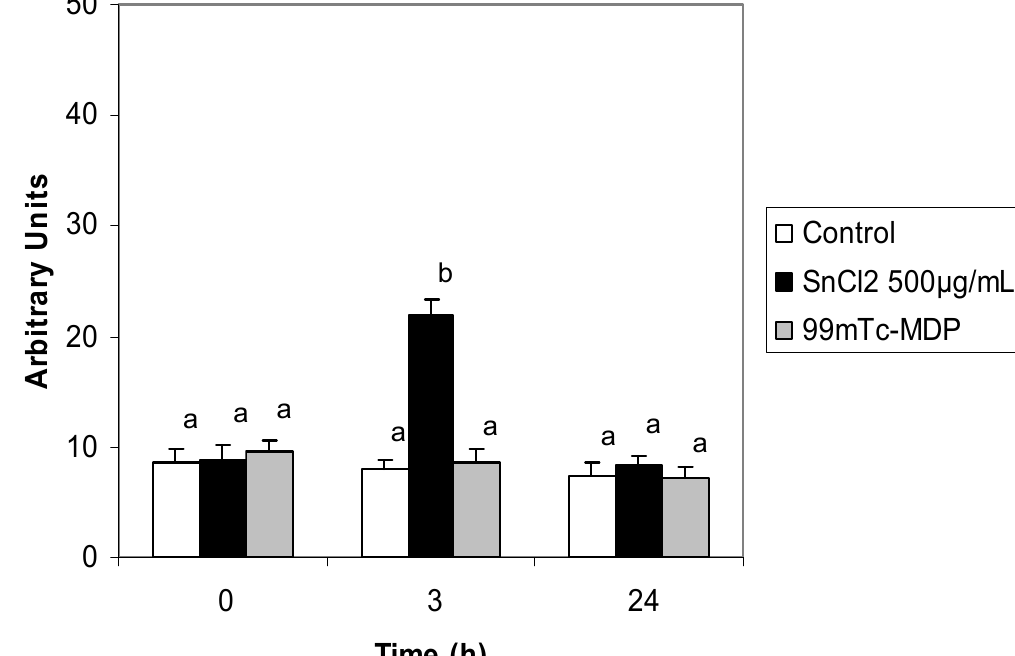
Figure 1. Comet assay of total blood cells of Wistar rats treated with NaCl 0.9% (Control); 500 µg/mL and 99m Tc-MDP. Blood was collected immediately before intravenous SnCl 2 injections and in time intervals of 3 and 24 h after chemical solution administration. Results for each procedure comprise means from three experiments; error bars represent standard error mean. Different letters (a,b) correspond to significant ( p < 0.05) statistical